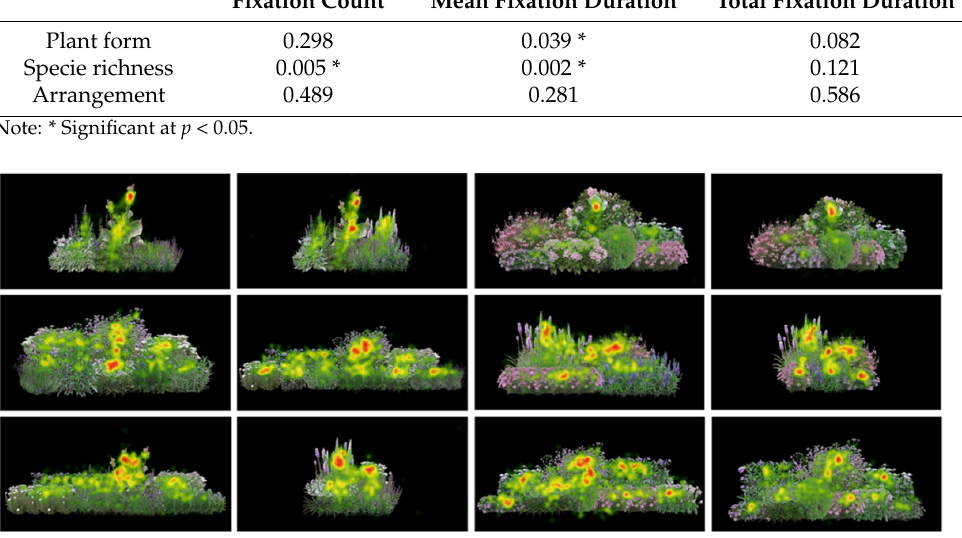
Figure 5. Eye-tracking heat maps of fixation duration of all participants on perennial combinations.